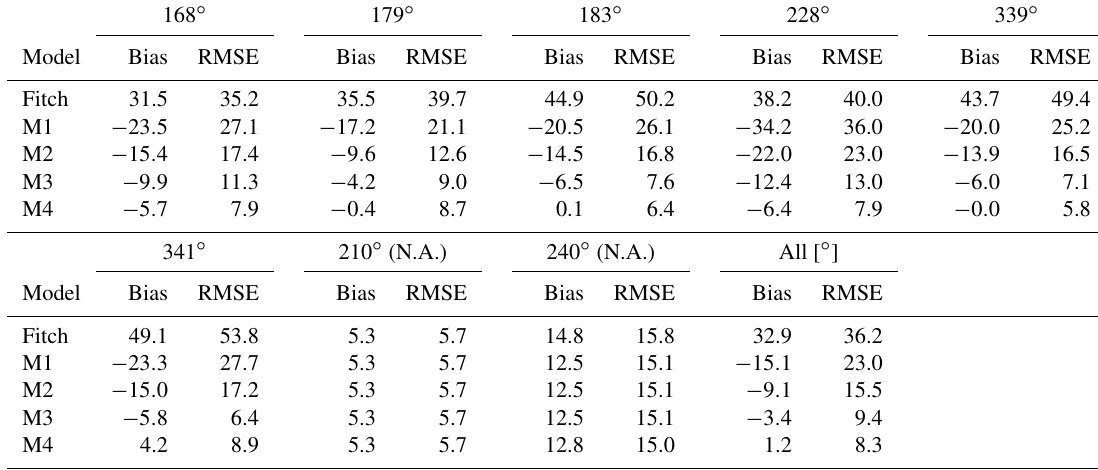
Figure 5. Same as Fig. 4 but for Anholt (single cell) with the directions of alignment (a–f) and the directions of non-alignment (g, h) . Table 2. As in Table 1 but at Anholt for single-cell cases (in percent). The results are from